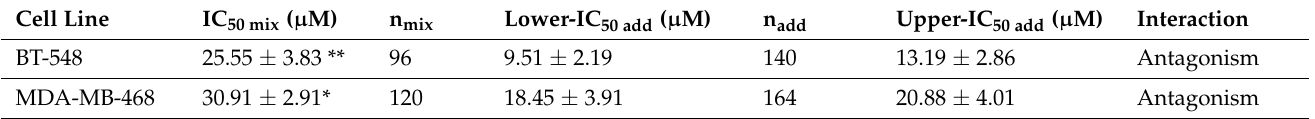
MDA ‐ MB ‐ 468 TNBC (Table 2; Figure 5B). Statistical analysis of data with Student’s t ‐ test additively calculated IC 50 add values (18.45 µ M-the lower IC 50 add and 20.88 µ M-the upper IC 50 add ; t = 2.022; df = 275.3; p = 0.0441; Table 2, Figure 5B). Table 2. Isobolographic analysis of interactions between PAX and CAM in BT-548 and MDA-MB-468 TNBC cells. The IC 50 values (in µ M ± SEM) for two-drug mixtures were determined experimentally (IC 50 mix ) and theoretically calculated (IC 50 add ) from the equations of additivity in the BT-548 and MDA-MB-468 TNBC cell lines measured in vitro by the MTT assay. n mix –total number of items for the experimental mixture; n add –total number of items for the additive mixture; * p < 0.05 and ** p < 0.01 vs. the respective IC 50 add values (Student’s t -test with Welch